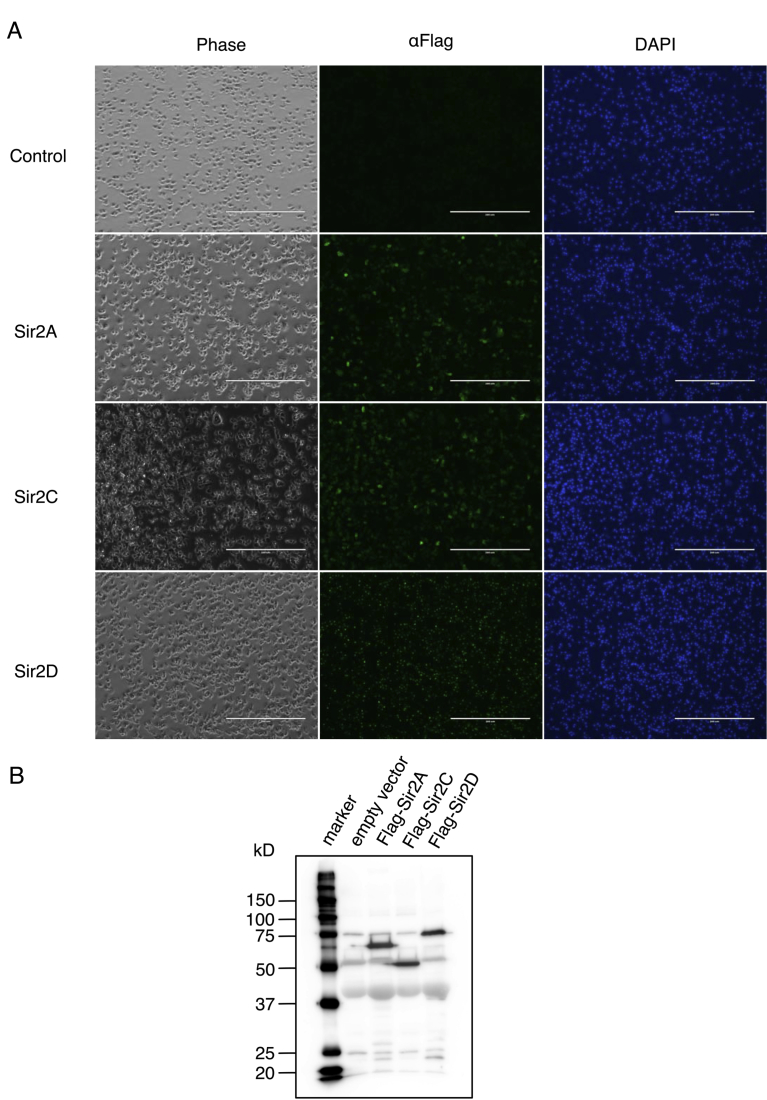
Supplementary Fig. S1.eps